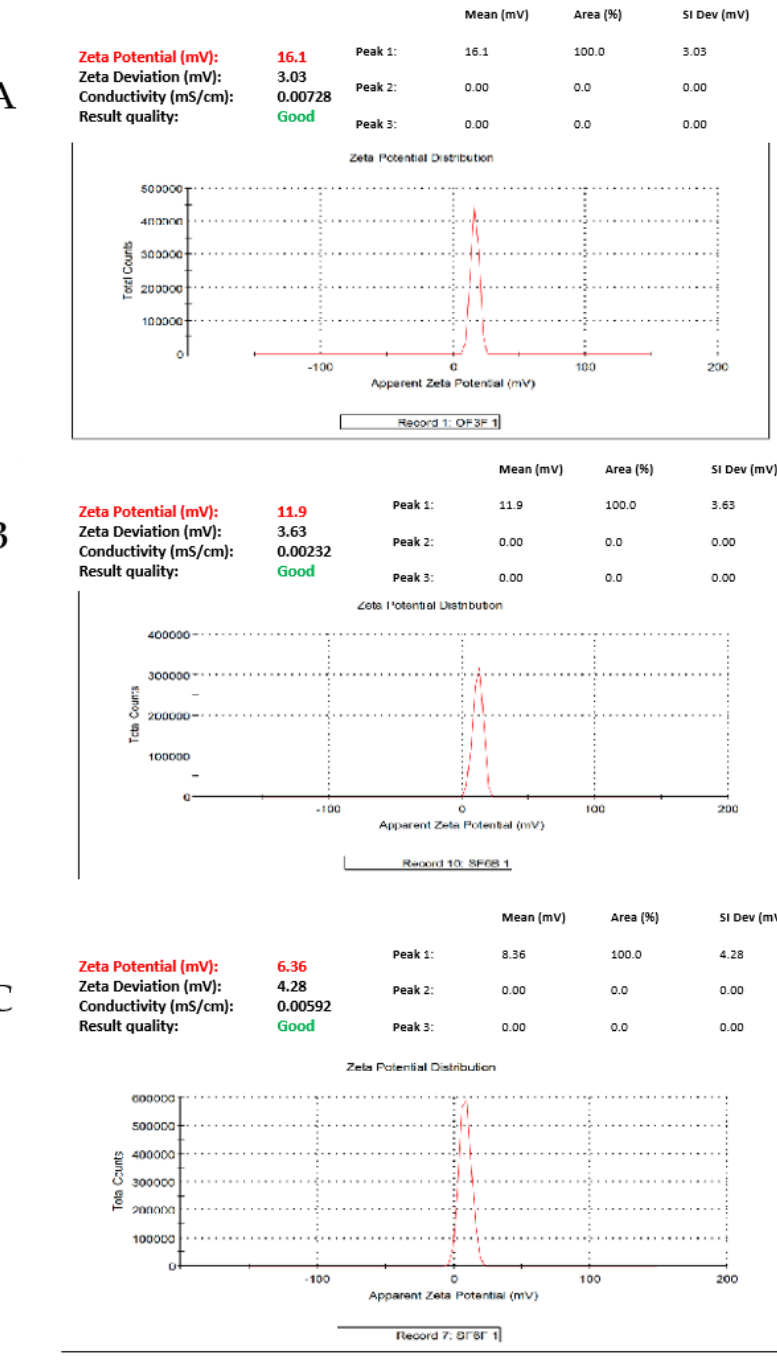
Figure 3. Zeta potential distribution of the optimised TAM-NE: ( A ) for NE1, ( B ) for NE9, and ( C ) for NE18.